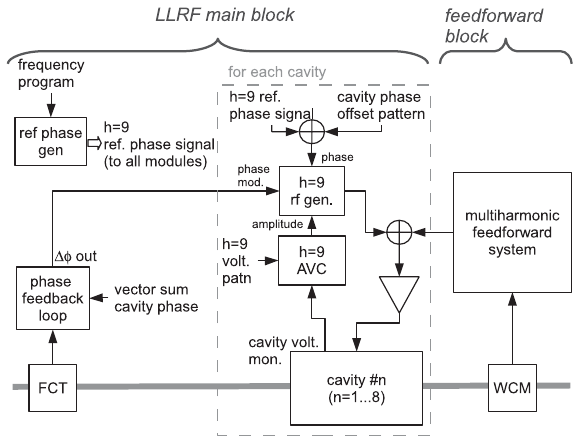
FIG. 2. A simplified block diagram of the MR LLRF control system.